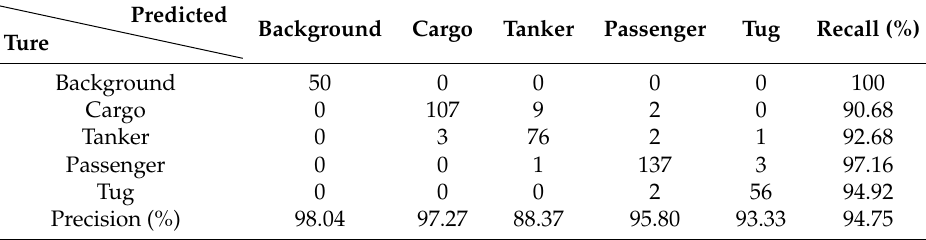
Table 3. Confusion matrix of